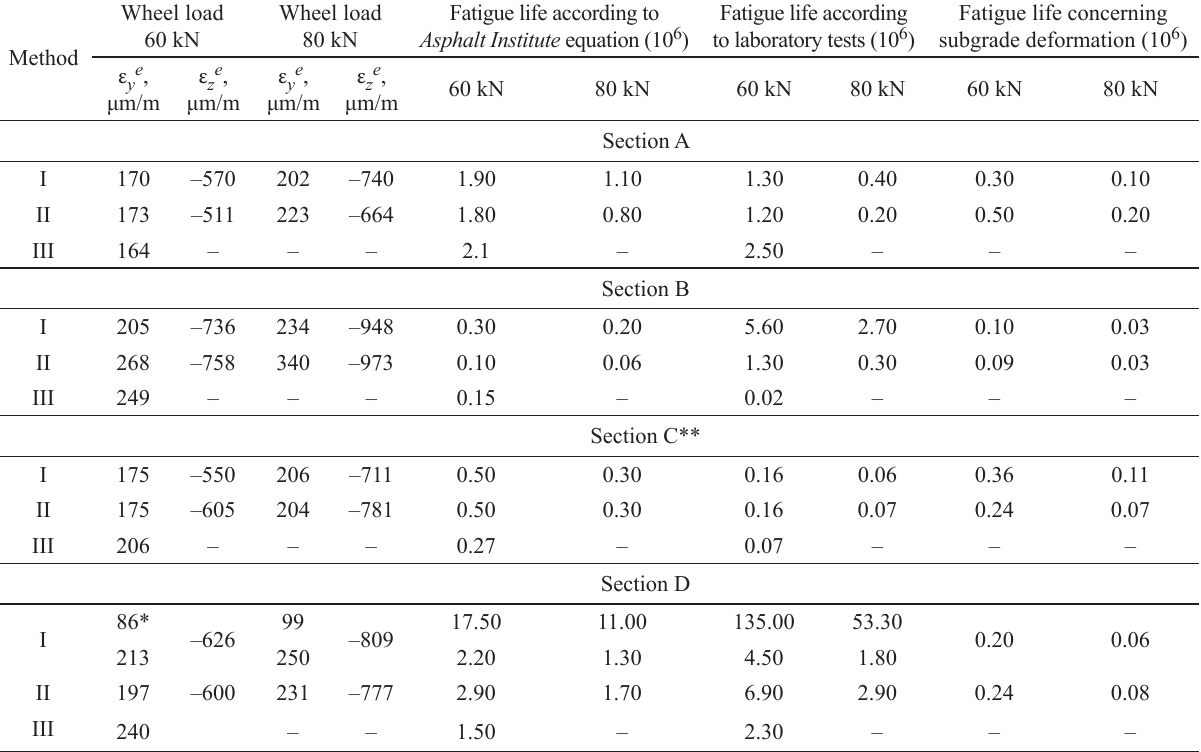
Table 5. Evaluation of pavement fatigue life